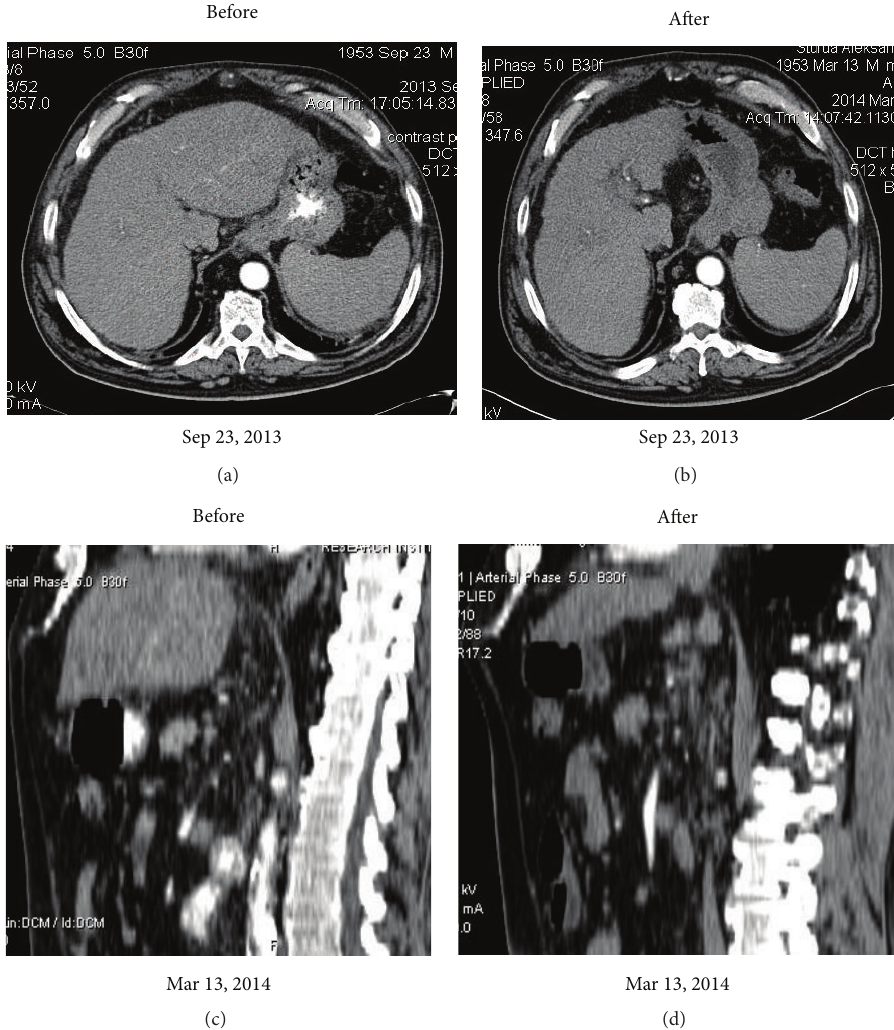
Figure 3: Comparison: CT before and in 5 months after VesOpen procedure. Note the decreased size and normal shape of the left